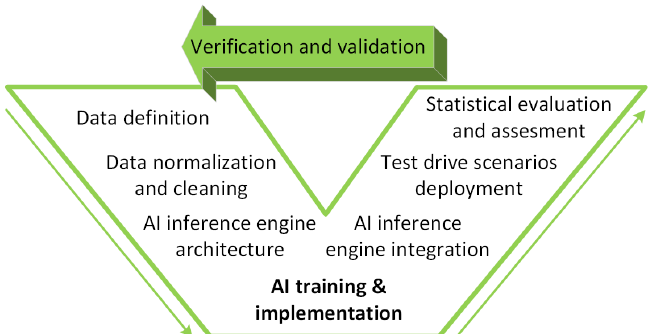
Figure 2. Data driven V-Model development of AI Inference Engines. The proposed V-model encompasses a synergy of data driven SiL and HiL design, training and evaluation of AI components.